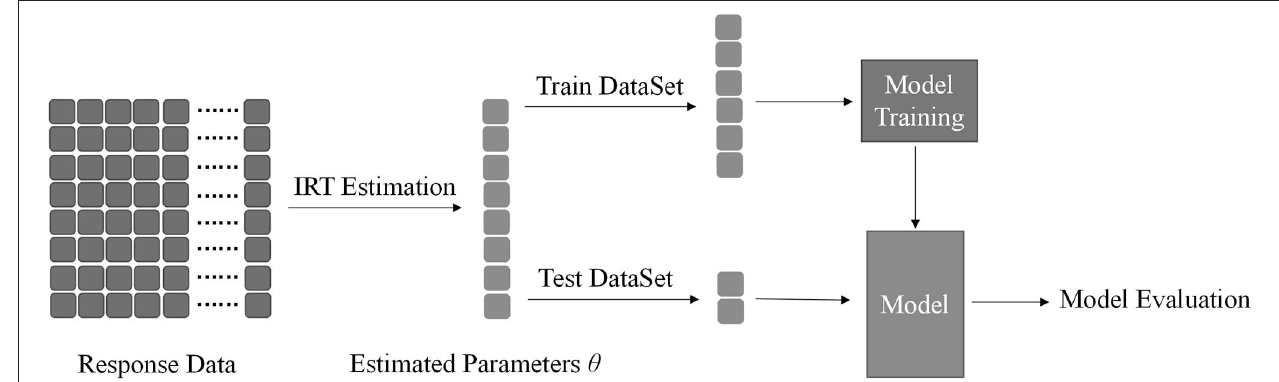
FIGURE 1 | The shape of response data is n × m , where n is the number of subjects and m is the number of items. After estimation, it can return a vector of parameters θ , where its length is n as the same as the number of subjects. The vector is used as the input of the classification method mentioned above. Estimated